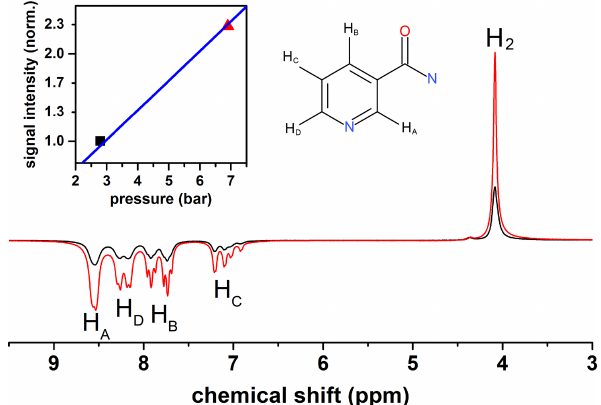
Figure 10. 1 H-SABRE spectra of nicotine amide and H 2 at 6.9 bar and 2.8 bar p H 2 pressure. (Insert): signal intensity of nicotine amide vs. pressure with a linear fit (blue line). Nicotine amide structure is added for